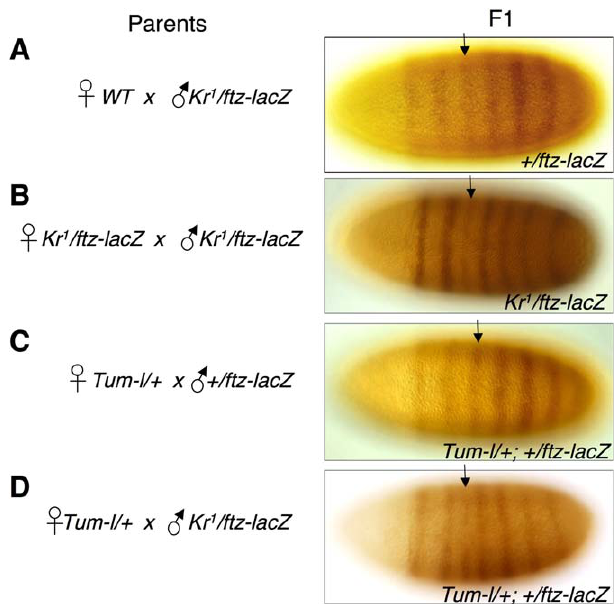
Figure 2. Maternal hop Tum-l Maintains Kr 1 Mutant Phenotypes in Absence of Kr 1 ftz expression pattern in stage 4 embryos from a ftz-lacZ transgene carried on the CyO balancer chromosome was analyzed by anti- b -gal staining. Embryos were produced by crosses indicated to the left. Note the wild-type ftz expression pattern in (A) and (C). Also note that the ftz stripe 3 (arrow) is faint or missing Kr 1 heterozygotes (B) or in progeny from hop Tum-l/ þ females and Kr 1 /ftz-lacZ males (D), which did not